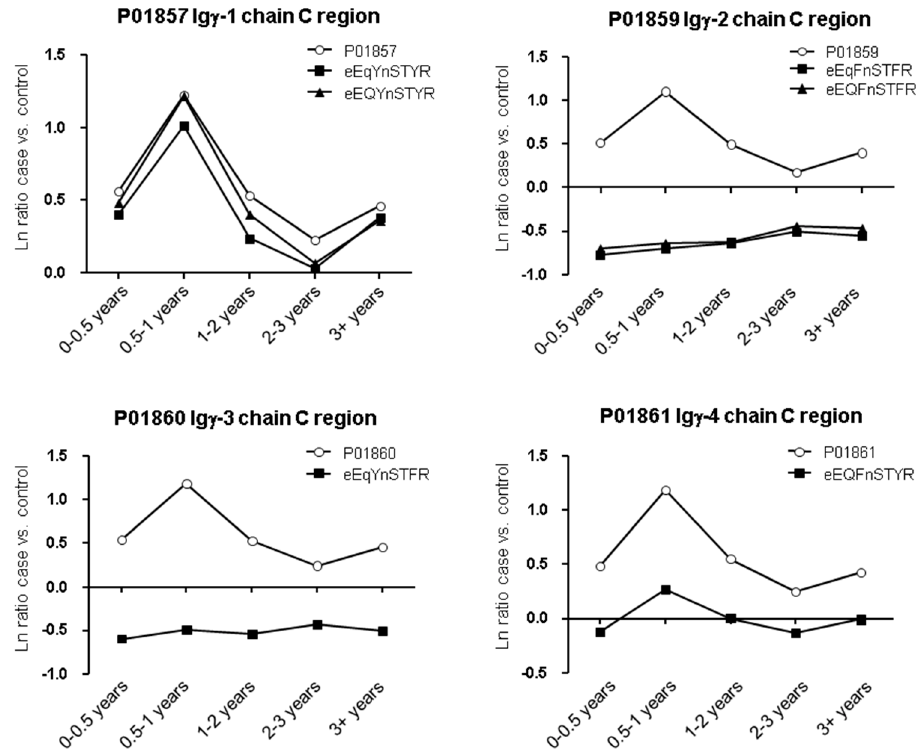
Figure 3. Expression of immunoglobulin G heavy chains and constituent glycopeptides. Graphs show the median natural log (ln) ratio of case versus control for protein (open circles) at each time group prior to diagnosis of pancreatic cancer. Protein ratios were derived from TMT reporter ion intensity ratios for all peptides matching that protein from analysis of the TiO 2 non-bound fractions (Table S6) to mitigate the significant effect that glycopeptide count had on the total protein ratio; IGHG2 glycopeptide counts represented more than half of total peptide counts. Closed symbols show the ln ratio across time groups for specific matched glycopeptides using reporter ion intensity ratios from the combined analysis.